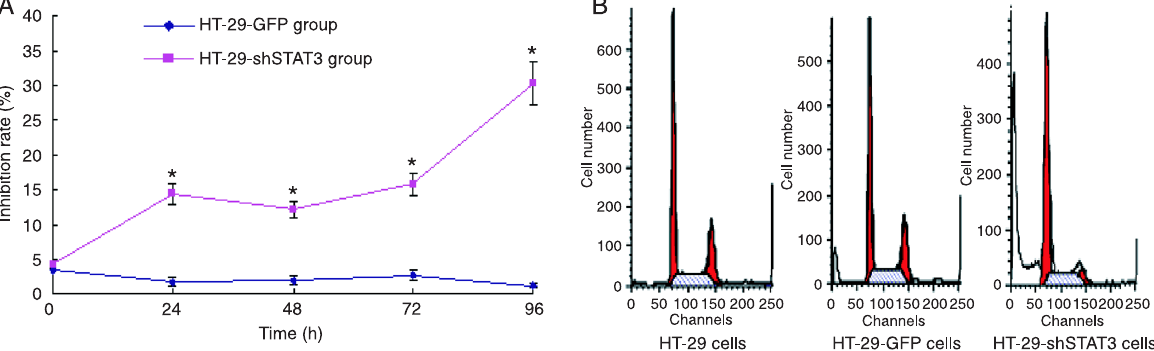
Figure 3. A , Growth inhibition curves of HT-29-shSTAT3 and HT-29-GFP cells. Data are reported as means ± SEM (N = 3). *P < 0.01, significantly different from the HT-29-GFP group (ANOVA). B , Cell cycle of each cell group. Cell cycle analysis showed that the proportion of G 0 /G 1 of HT-29 cells and HT-29-GFP cells was 38.65 ± 2.33 and 38.48 ± 1.63%, respectively. The percentage of HT-29- shSTAT3 cells at G 0 /G 1 was 68.73 ± 2.88%, much higher than that of HT-29-GFP cells and HT-29 cells (P <